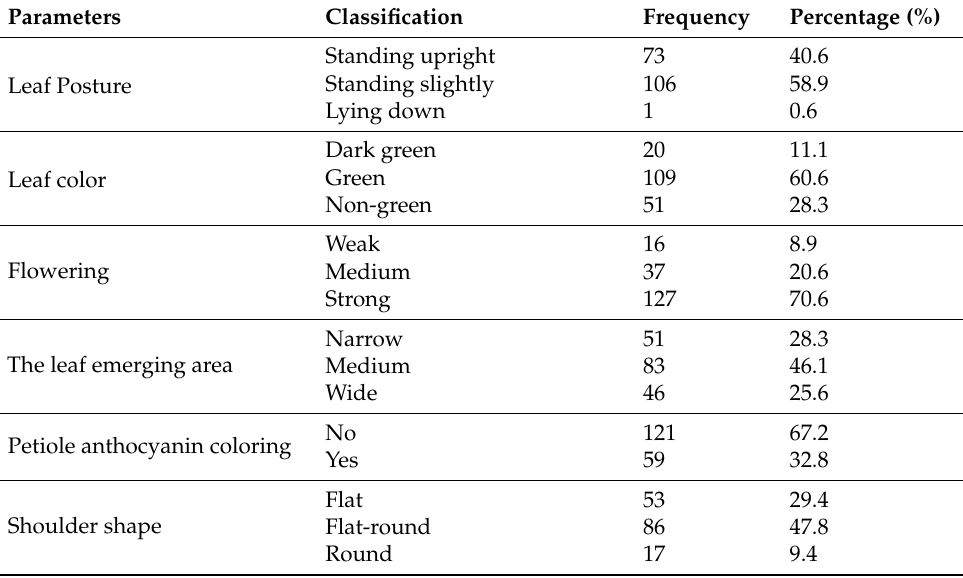
Table 1. Frequency distribution of 15 qualitative parameters in 180 carrot genetic